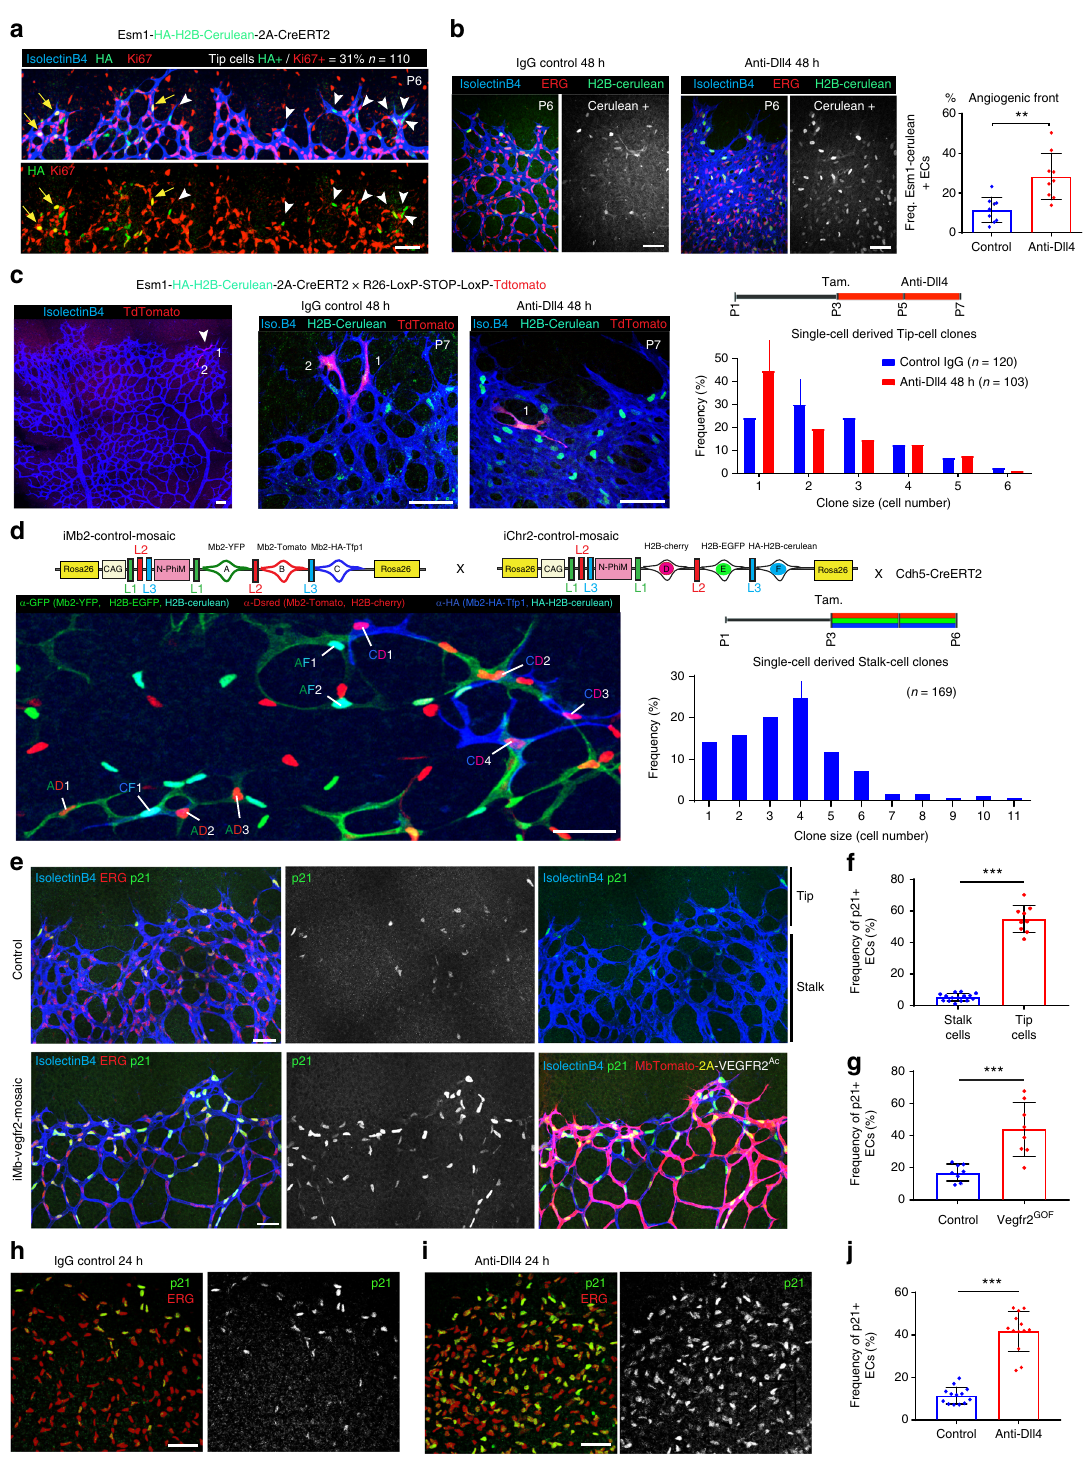
Supplementary Fig. 4f — IgG 24 h bar). Dll4/Notch signalling blockade induced a marked increase in the number of Esm1- expressing stalk cells (Fig. 4b), similar to our fi ndings with P-ERK (Fig. 3a). Thus, while VEGF induces high P-ERK and Esm1 levels in tip cells, in stalk cells this induction is suppressed by the higher Notch activity in these cells. To genetically pulse-label single endothelial tip cells and track their proliferative dynamics, we crossed Esm1-HA-H2B-Cerulean- NATURE COMMUNICATIONS|